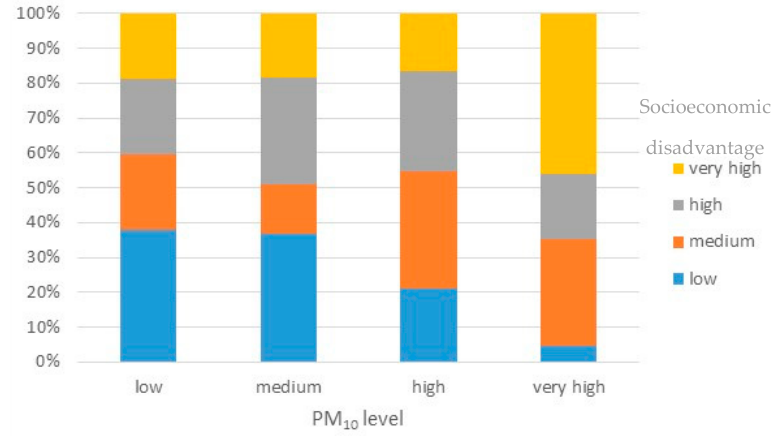
Figure 5. Proportion of socioeconomically-disadvantaged inhabitants per neighborhood in quartiles vs. the proportion of area per neighborhood impacted by PM 10 above the 25 μ g/m 3 annual mean in quartiles.